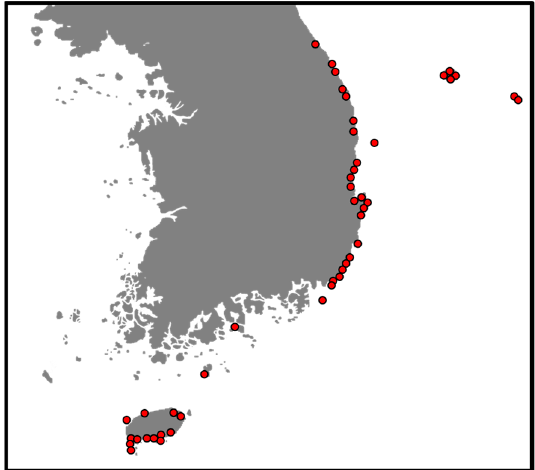
Figure 1. Map of study sites each area of Korea.